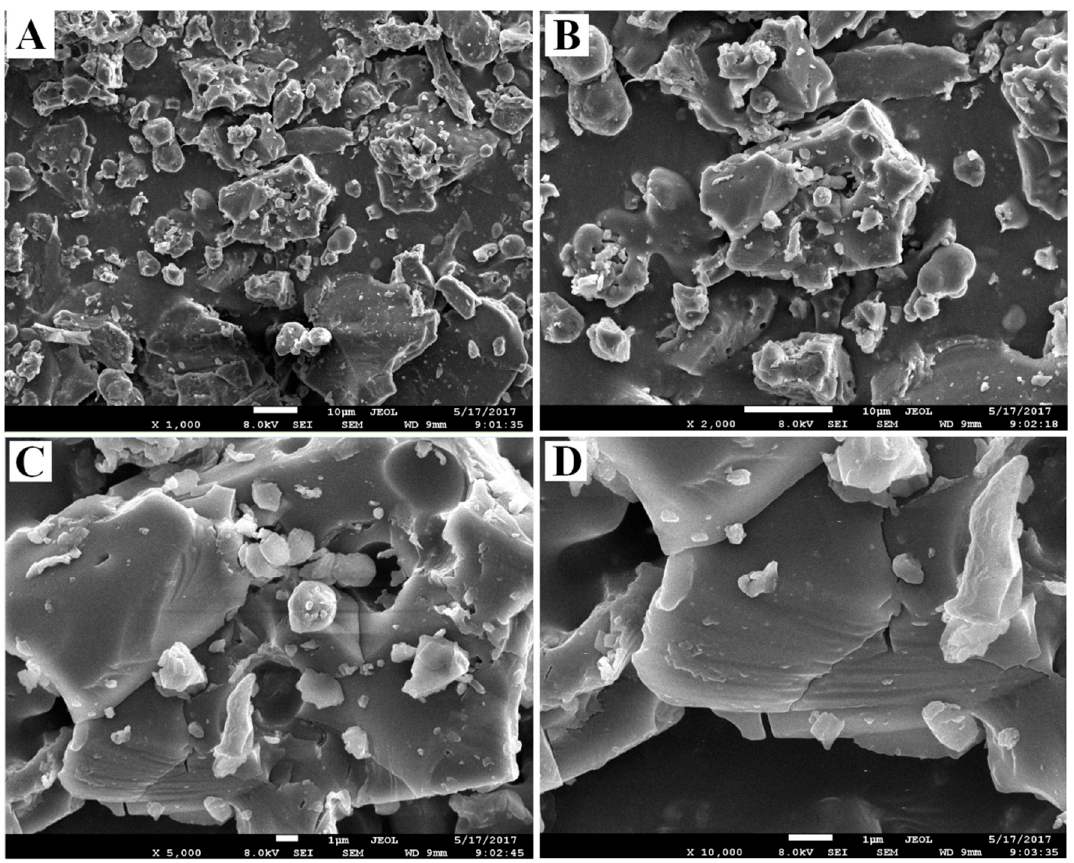
Figure 5. SEM images of PSA. ( A ) Morphology at 1000× (scalebar is 10 μ m); ( B ) Morphology at 2000× (scalebar is 10 μ m); ( C ) Morphology at 5000× (scalebar is 1 μ m); ( D ) Morphology at 10,000× (scalebar is 1 μ m).